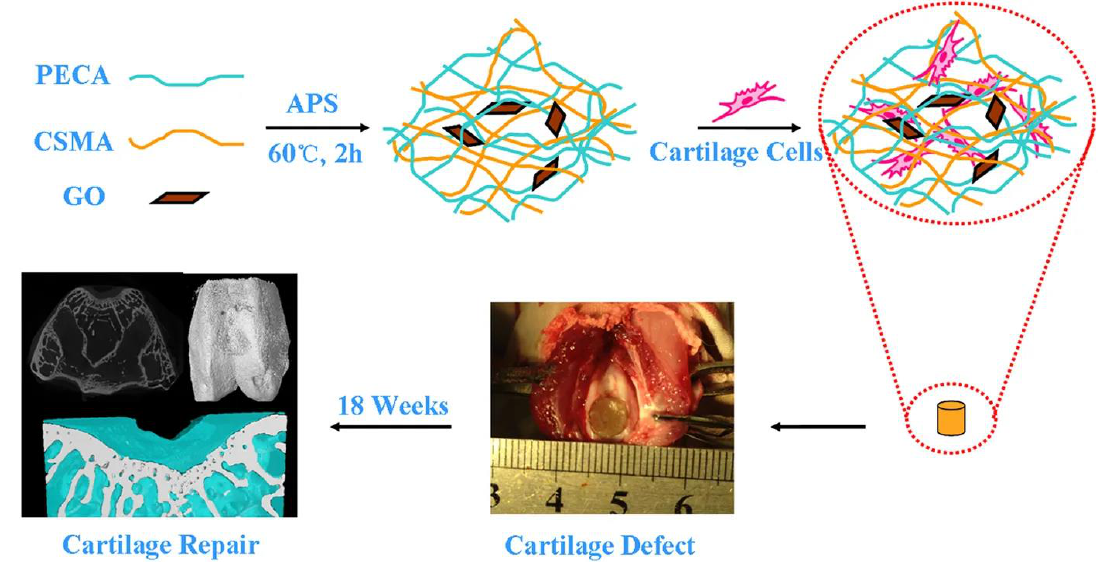
Figure 1. CSMA / PECA / GO hybrid sca ff old for cartilage regeneration. Adopted from [169], under the Figure 1. CSMA/PECA/GO hybrid scaffold for cartilage regeneration. Adopted from [169], under the terms and conditions of the Creative Commons Attribution (CC BY) terms and conditions of the Creative Commons Attribution (CC BY) license.